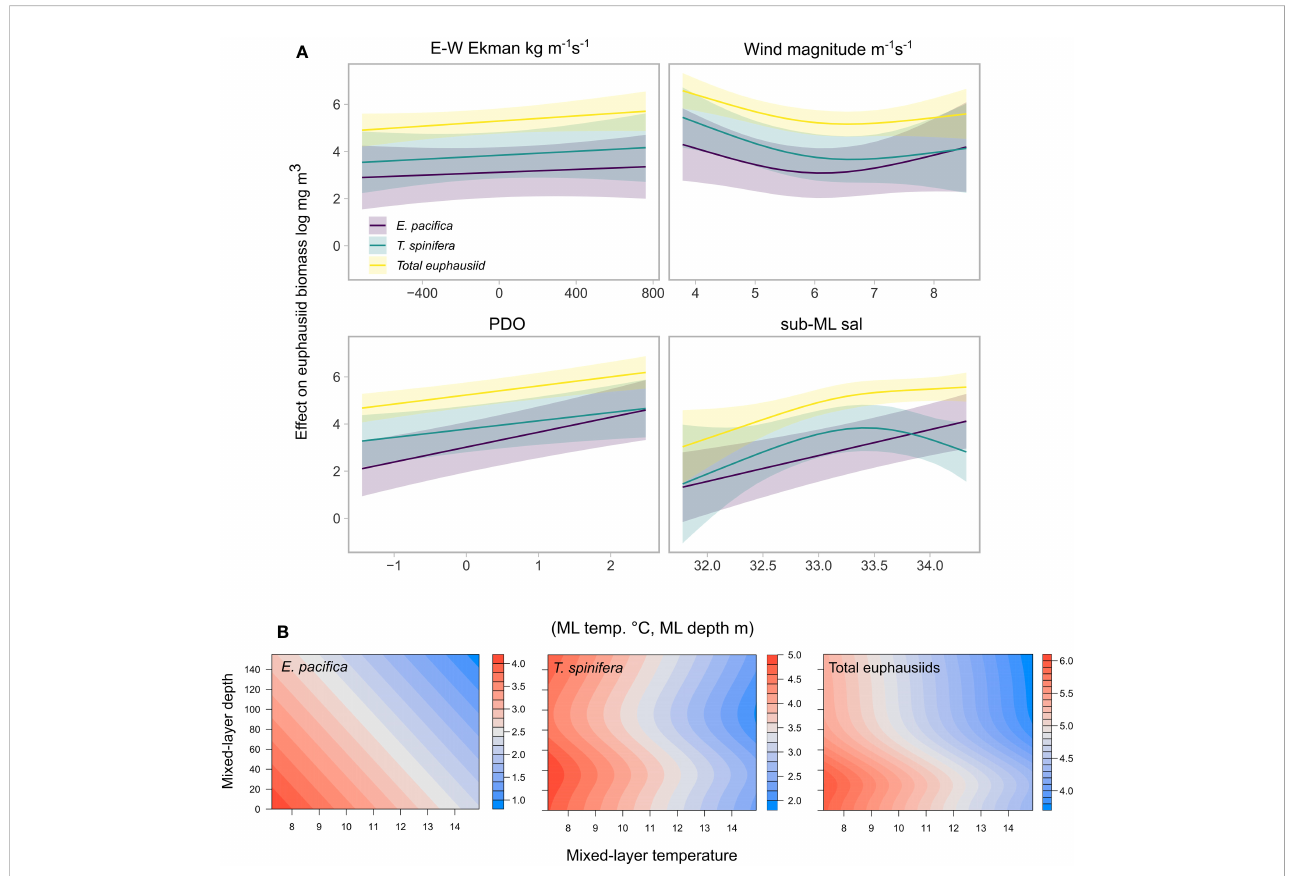
FIGURE 5 Conditional effects plots for each variable used in spatiotemporal modelling of E. paci fi ca , T. spinifera , and total euphausiids, with all other variables held at their median. (A) . X-axis represented the range of each predictor represented in the model; Y-axis represents the effect on the biomass of each euphausiid group on the link scale (log-link), shaded sections represent +/- 95% con fi dence interval above and below the estimate of the smooth. (B) . The conditional effects of the smooth interaction of mixed-layer temperature and mixed layer depth for euphausiid biomass for each euphausiid